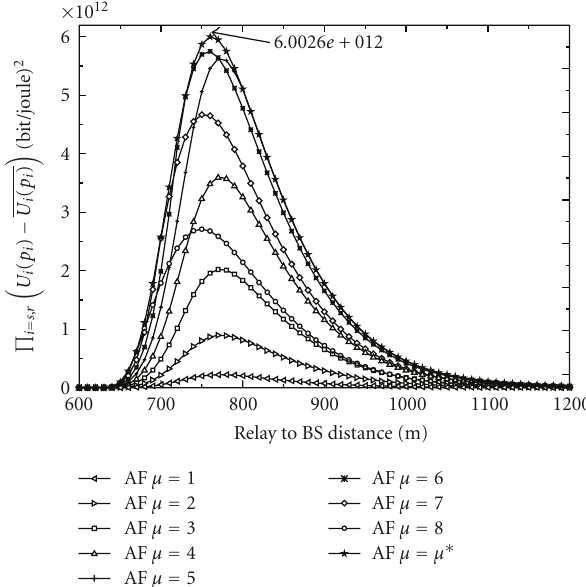
Figure 5: Value of ( U s ( p s ) − U s ( p s ))( U r ( p r ) − U r ( p r )) versus di ff erent locations of the relay under AF